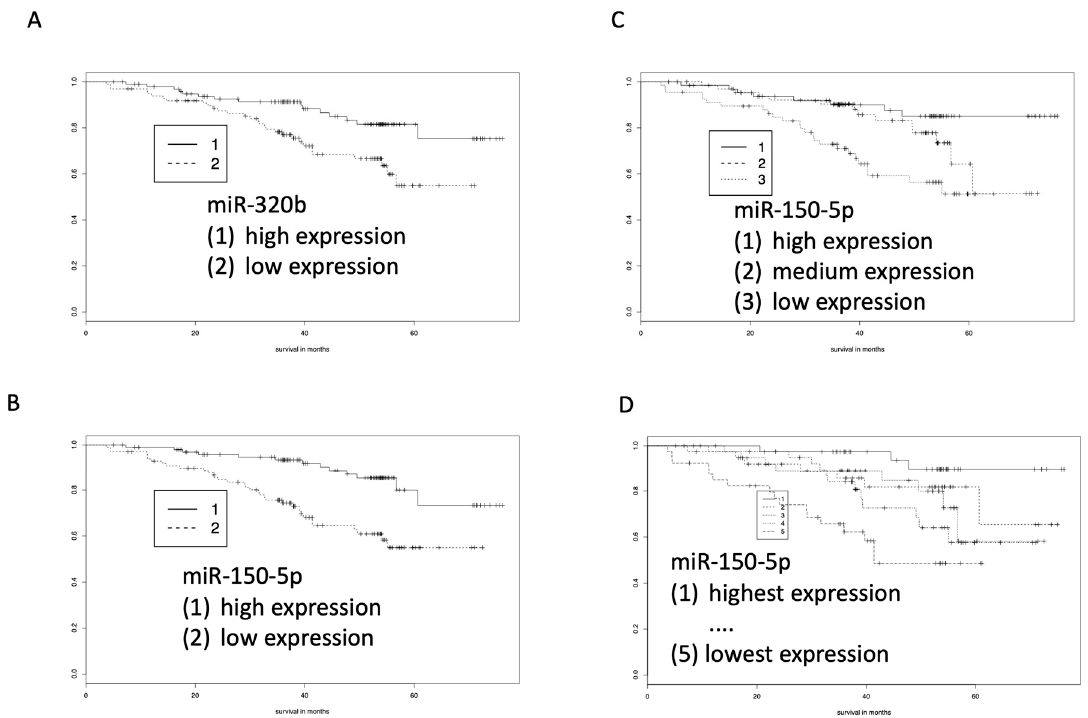
Figure 4. Kaplan-Meier analyses of blood-born miRNA patterns determined by RT-qPCR. ( A ) MiR-320b indicates longer survival of COPD patients who show higher abundance of miR-320b. ( B ) MiR-150-5p indicates longer survival of COPD patients who show higher abundance of miR-150-5p. ( C ) Splitting the patients in tertile groups with high, medium, and low expression of miR-150-5p showed longest survival for patients with highest expression. ( D ) Splitting in quintile groups also demonstrated the longest survival for patients with highest expression.